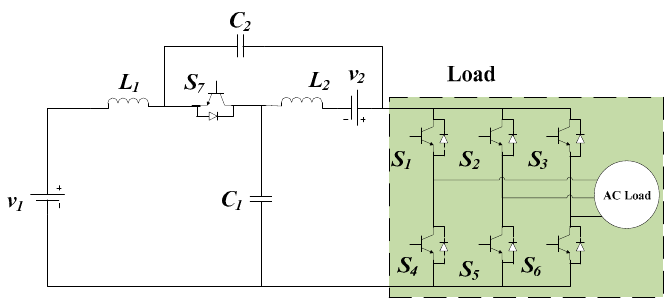
Figure 4. Bidirectional embedded quasi-Z-source inverter topology.